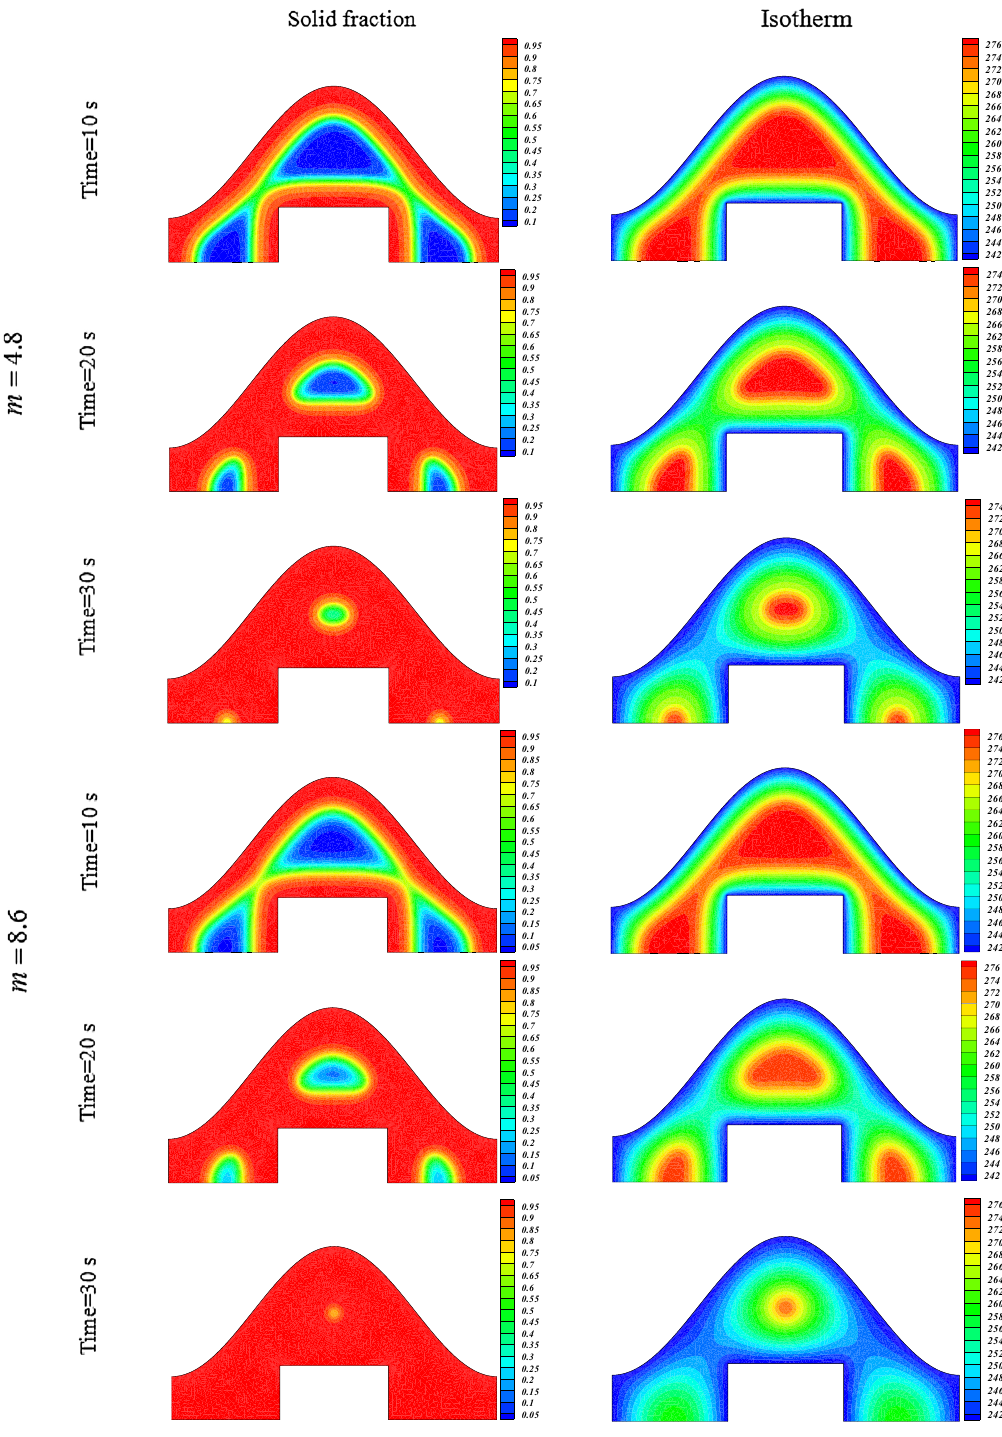
Figure 4. Impact of configuration of nano-powders on transient